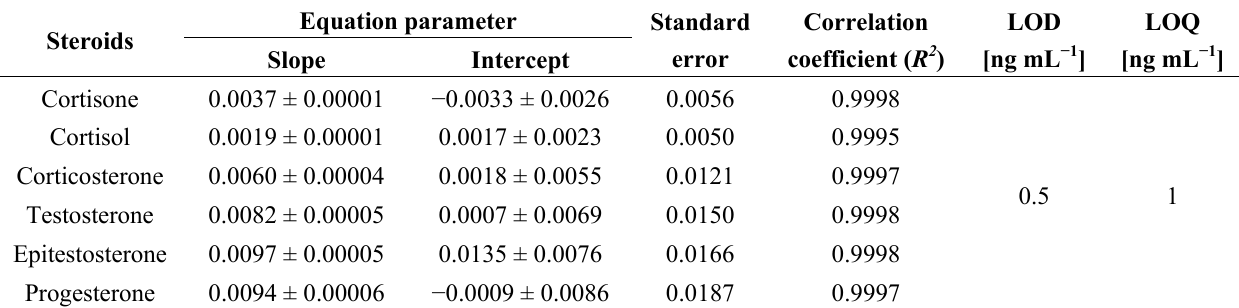
Table 1. Summary of validation data within a range of 1–300 ng mL − 1 for six steroid hormones in human urine obtained with LC calibrations (n =